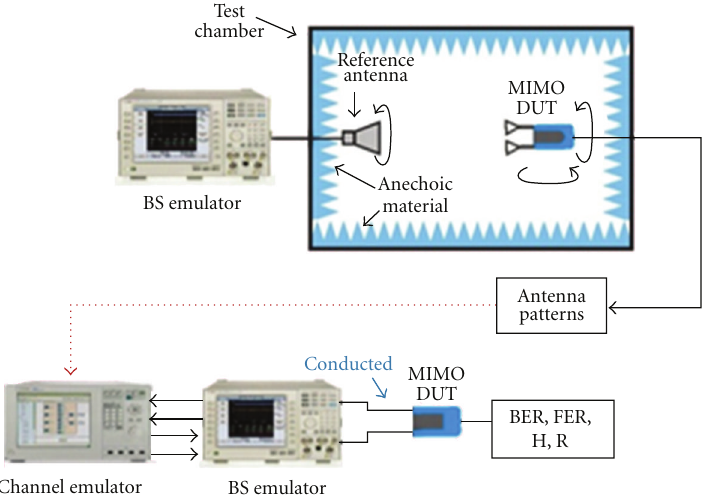
Figure 3: Proposed two-stage test methodology for MIMO OTA test (TR 37.976 [7] Figure 6 . 3 . 1 . 3 . 1-2).